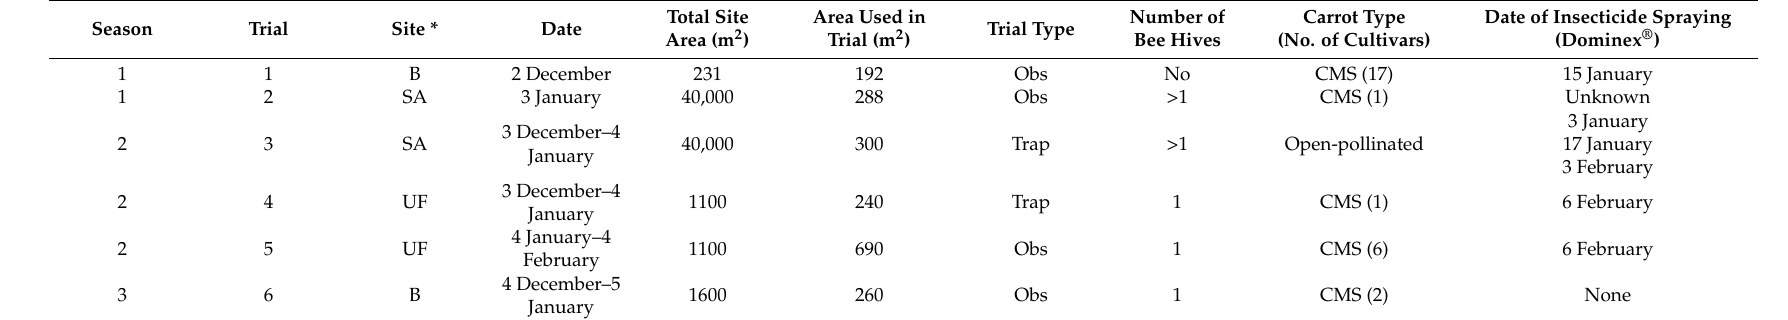
Table 1. Details of trials for insect